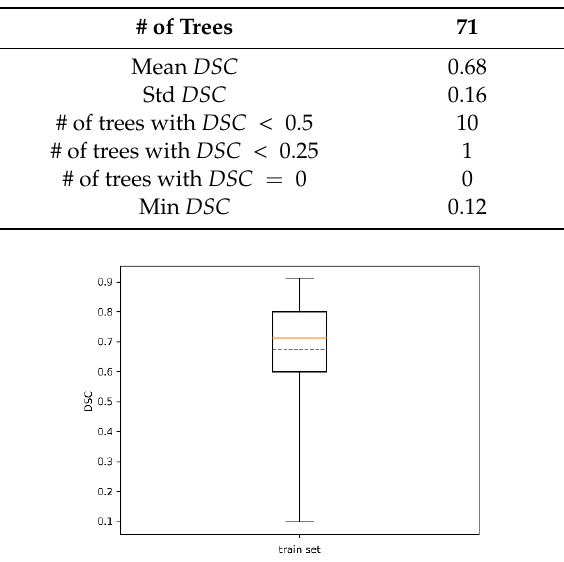
Table 3. Statistics of 𝐷𝑆𝐶 for the training set.